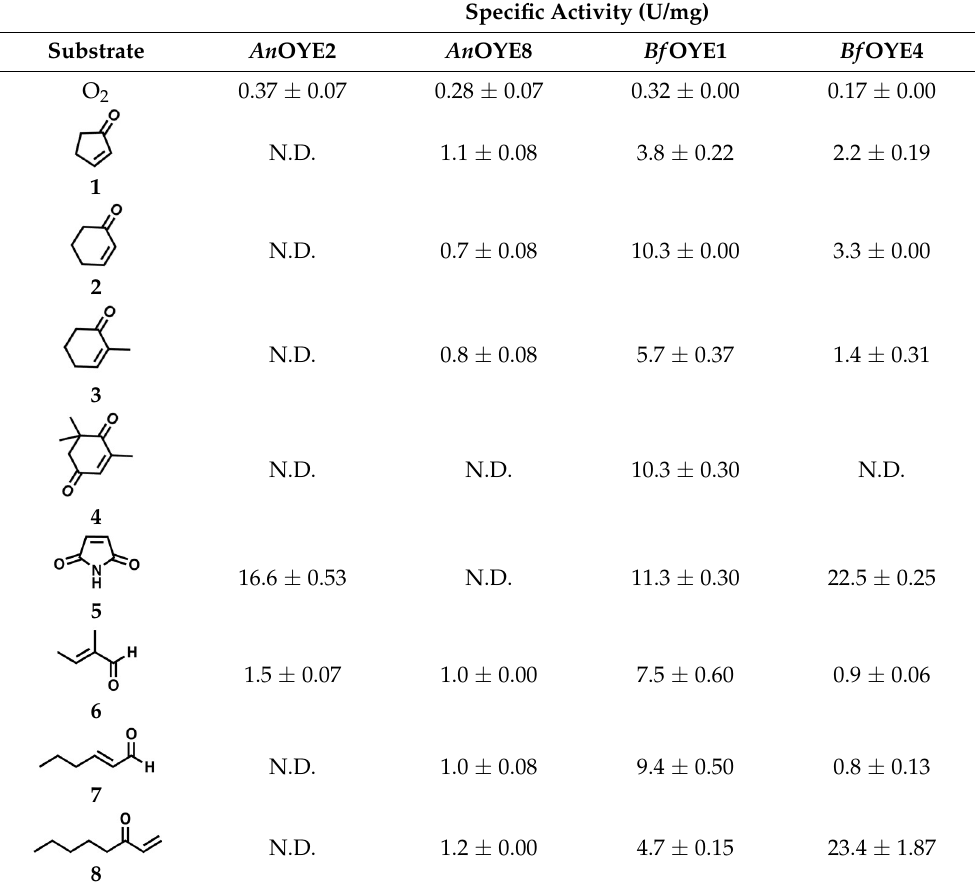
Table 1. Spectrophotometric substrate screening 1